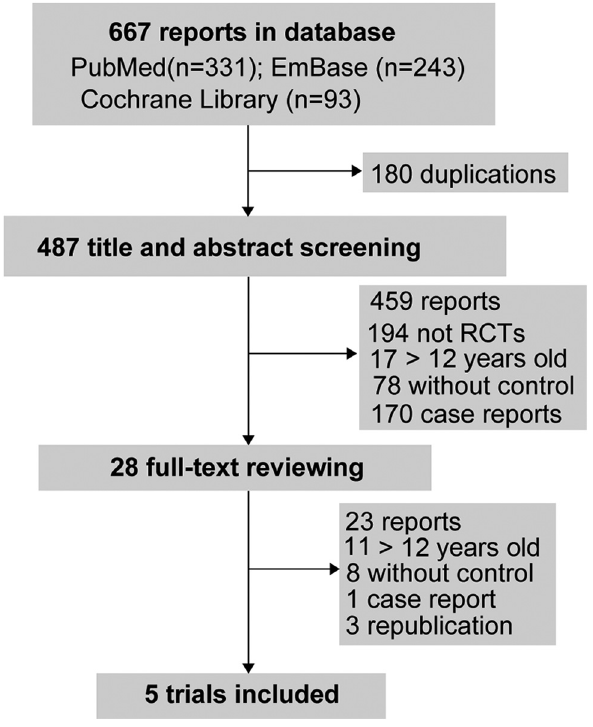
Figure 1: The fl ow diagram of study selection